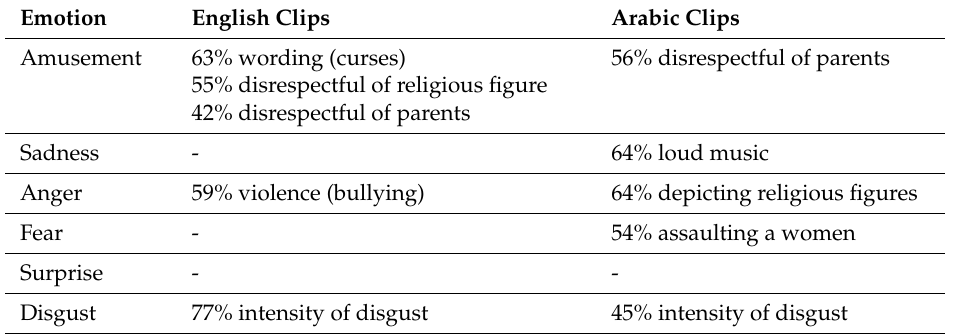
Figure 6. Cultural acceptance percentage for each of the emotion elicitation clips. Table 6. Main reasons for rejecting the selected clips including percentage of the given reason for